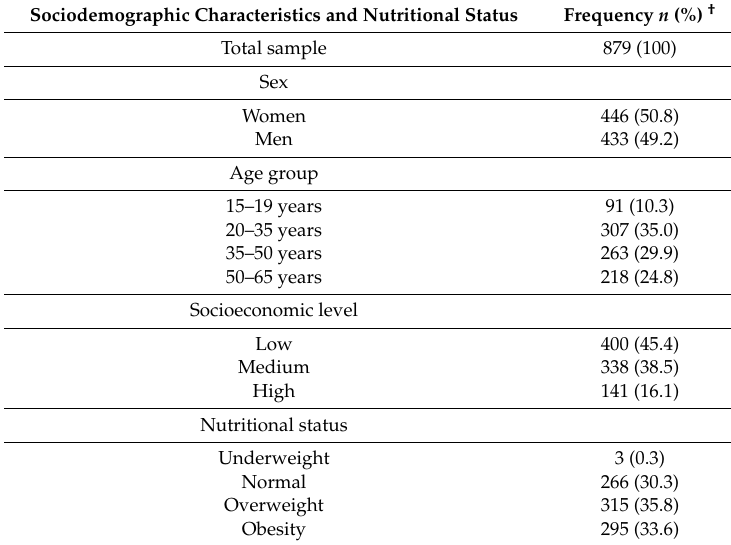
Table 1. Characteristics of Chilean participants enrolled in ELANS 2014–2015.